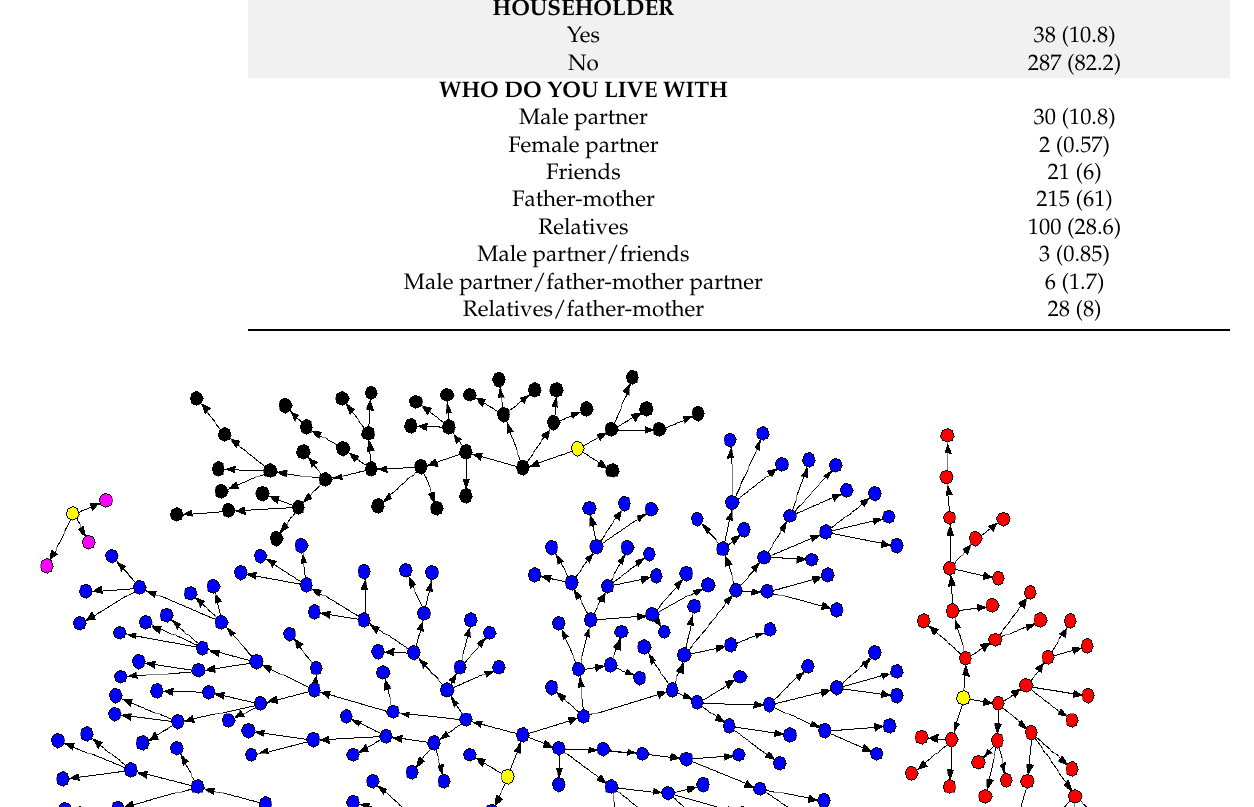
Table 1. Sociodemographic characteristics of men who have sex with men in Belém, Pará, Brazil, 2016.